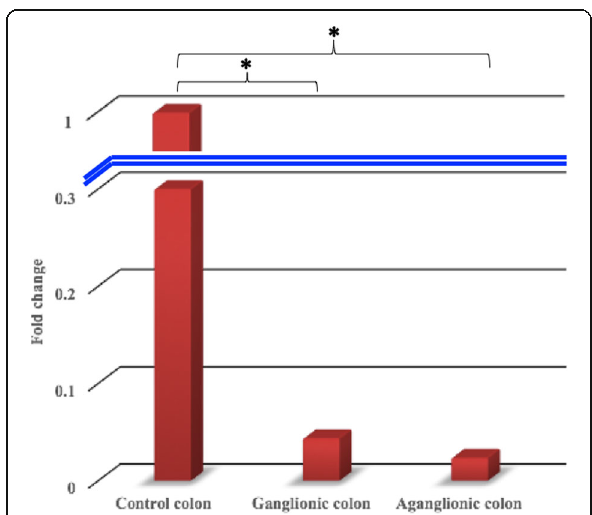
Fig. 1 The SK3 expressions in both the ganglionic and aganglionic colon of HSCR patients are significantly lower (23 and 43-fold, respectively) compared with the controls colon. Data represent the means ± SD of SK3 expression normalized to GAPDH and relative to control tissues. *, p <0.05